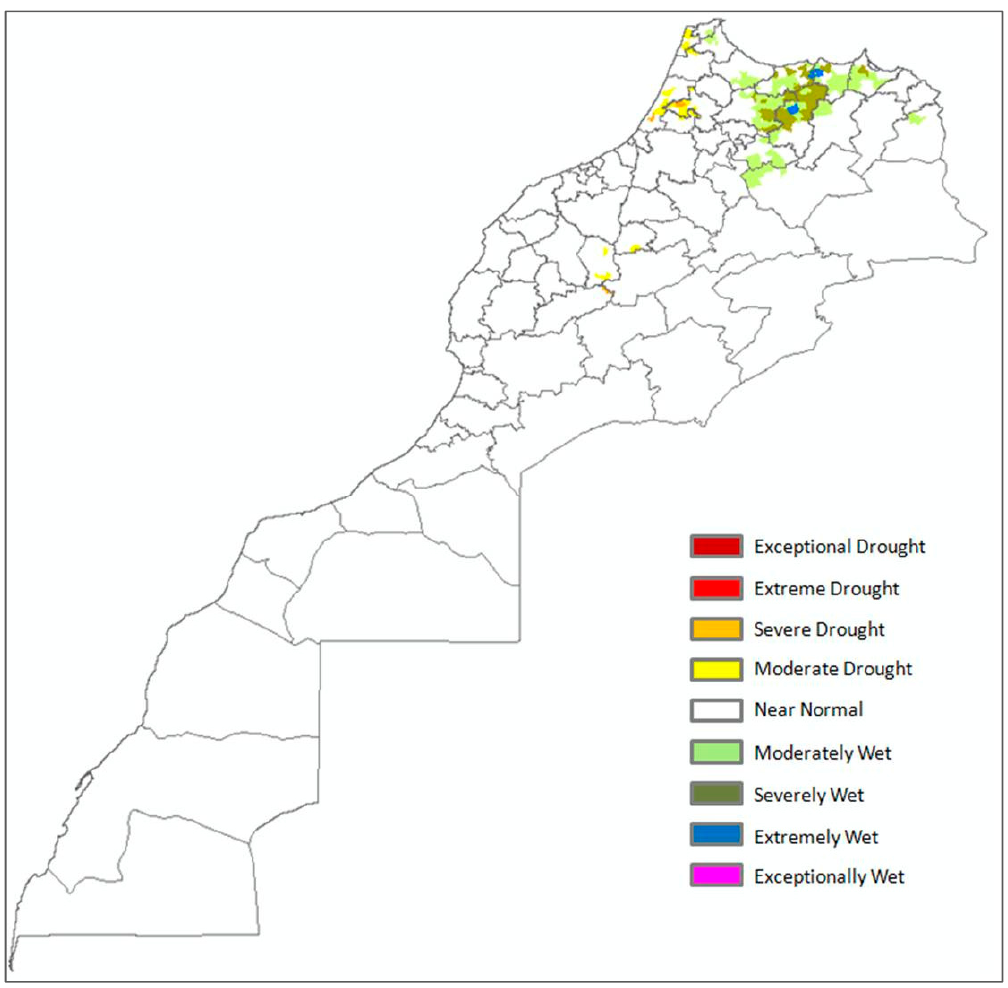
Figure 2. Example of the evapotranspiration (ET) anomaly for February 2016.